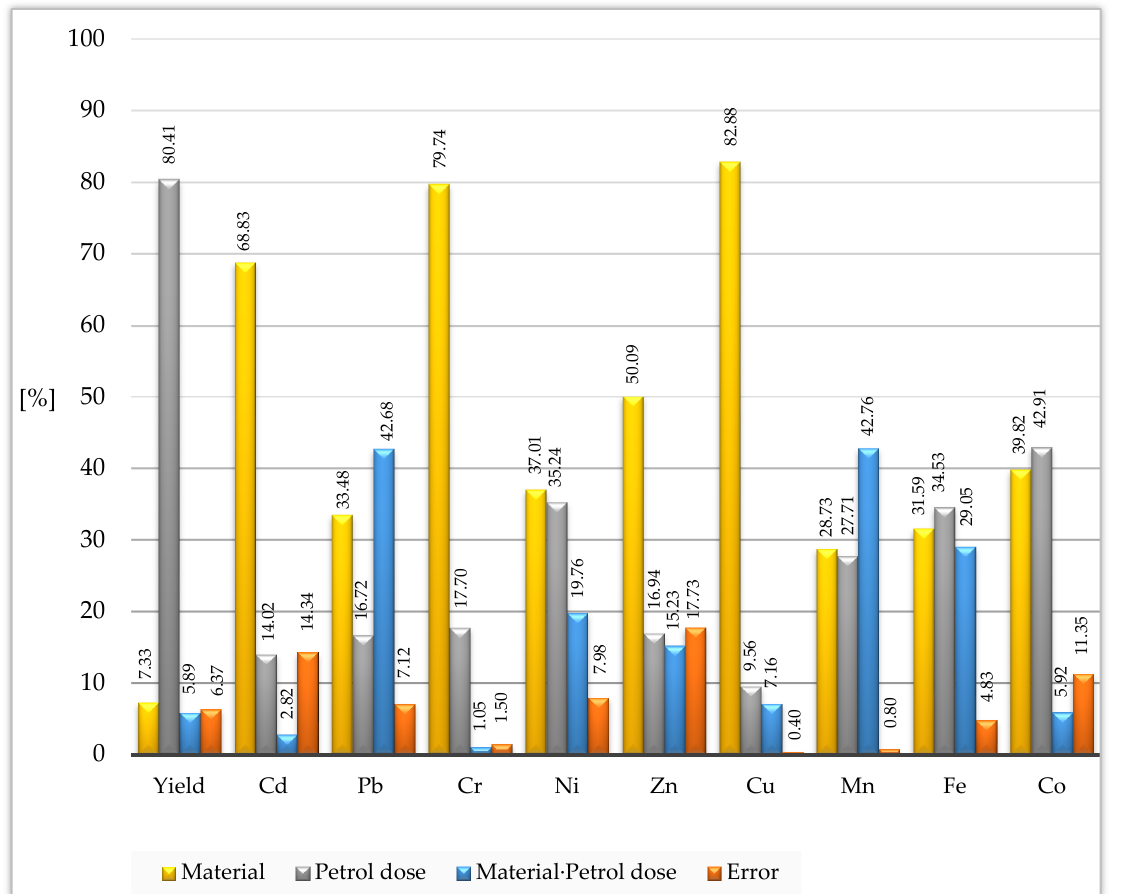
Figure 2. Percent contribution of variable factors according to the yield and content of heavy metals in aerial parts of maize ( Zea mays L.).